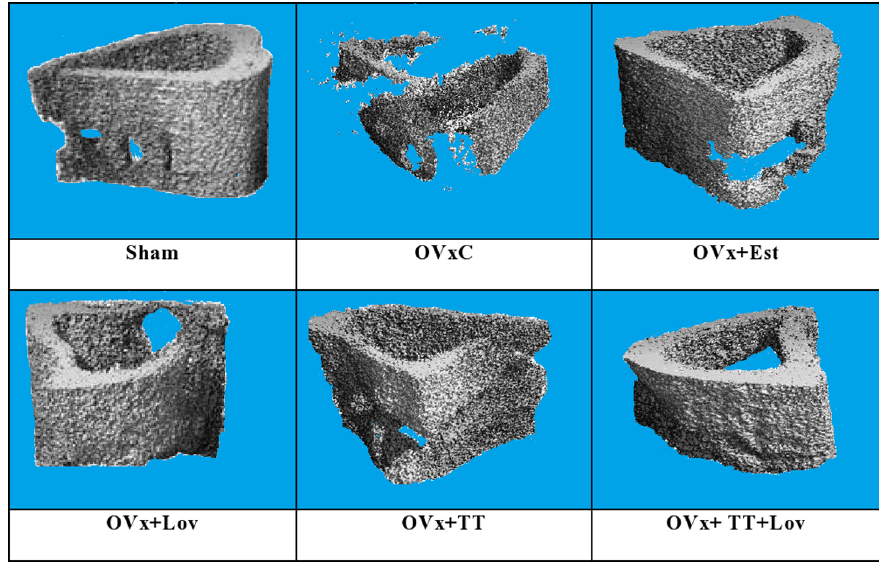
Fig. 6. Load, Stress, Strain and Young Modulus for all the groups after 4 weeks of treatment. Sham: sham-operated group, OVxC:variectomized control group, OVx + Est:ovariectomized + Estrogen, OVx + Lov:ovariectomized + Lovastatin, OVx + TT:ovariectomized + Tocotrienol, OVx + TT + Lov:ovariectomized + Tocotrienol + Lovastatin. *Indicates a significant difference (p , 0.05) compared with the ovariectomized control group (OvxC). The data were expressed as mean ¡